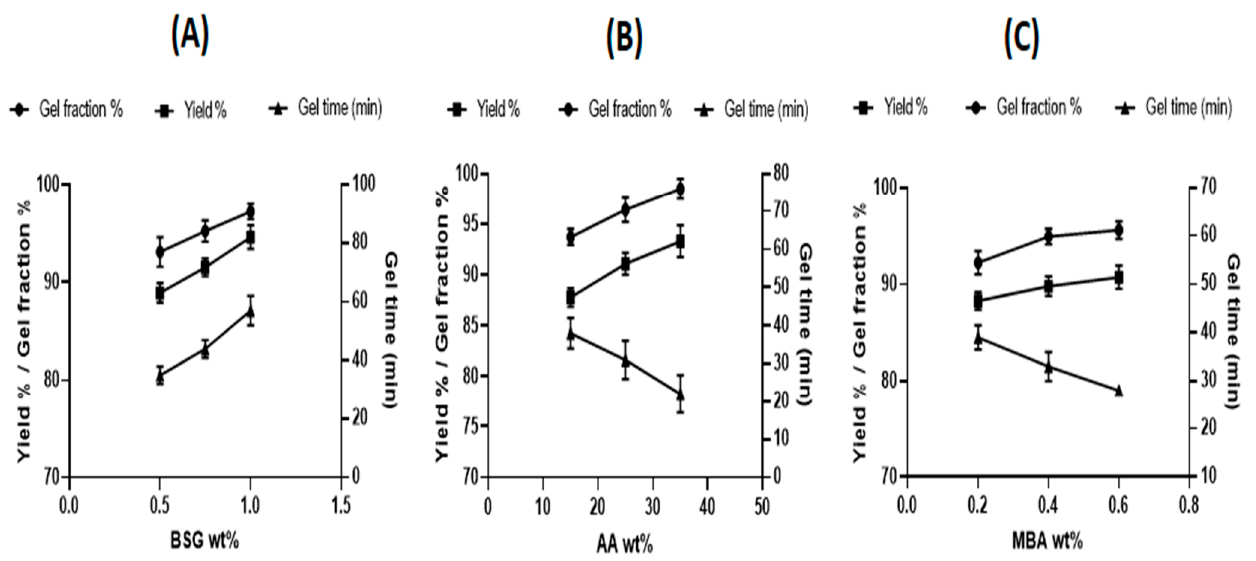
Figure 8. Effect of ( A ) BSG; ( B ) AA; ( C ) MBA on gel%, yield% and gel time.